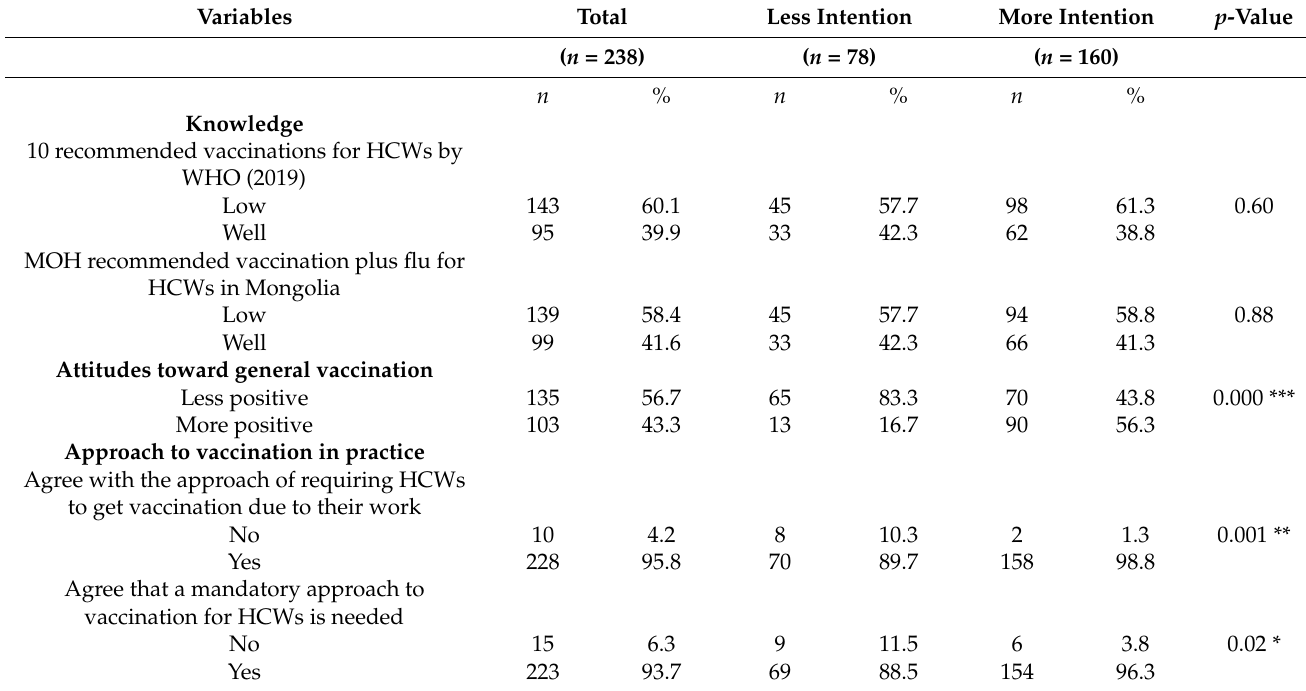
Table 2. Comparison of knowledge about the recommended occupational vaccine, practical vaccination behaviors, and attitudes toward the general vaccine among COVID-19 vaccination intention